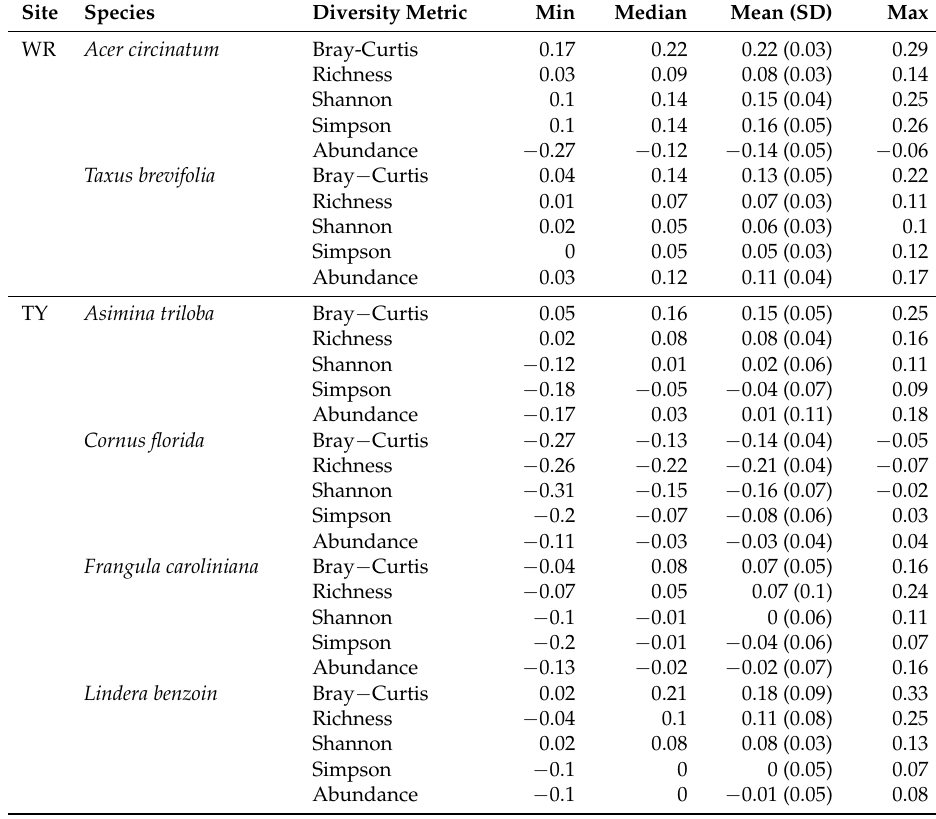
Figure A11. Statistical significance (red: P 0.05; blue: P > 0.05) of the codispersion coefficients ≤ calculated between measures of diversity and total basal area of the focal understory species in 20 20-m subplots in the 16-ha Luquillo ( Prestoea acuminata ) and 25-ha Amacayacu ( Rinorea lindeniana ) × plots (Figure A9). Statistical significance was determined by comparing observed codispersion at each spatial lag with a distribution of 199 spatial randomizations of a CSR null model. Table A3. Codispersion statistics for focal understory species in temperate forests (Figures A6–A8).